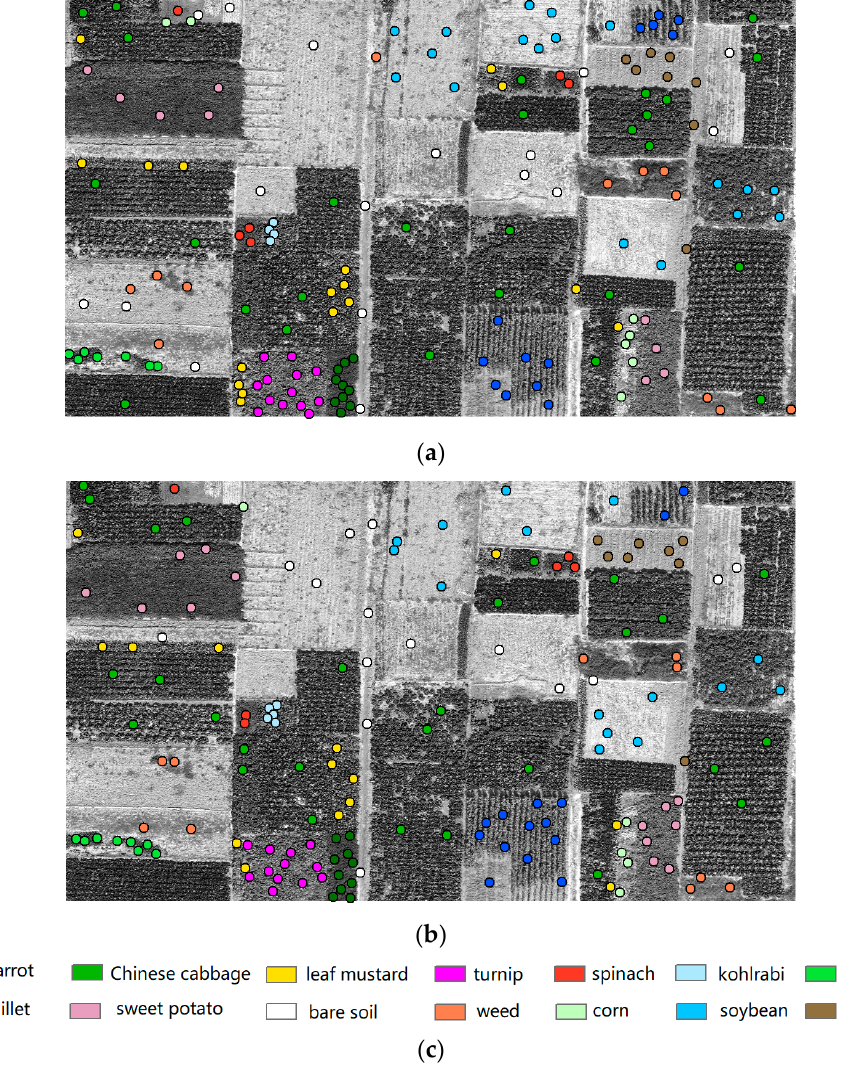
Figure 2. Spatial distribution of ( a ) training samples; ( b ) testing samples; ( c ) legend.